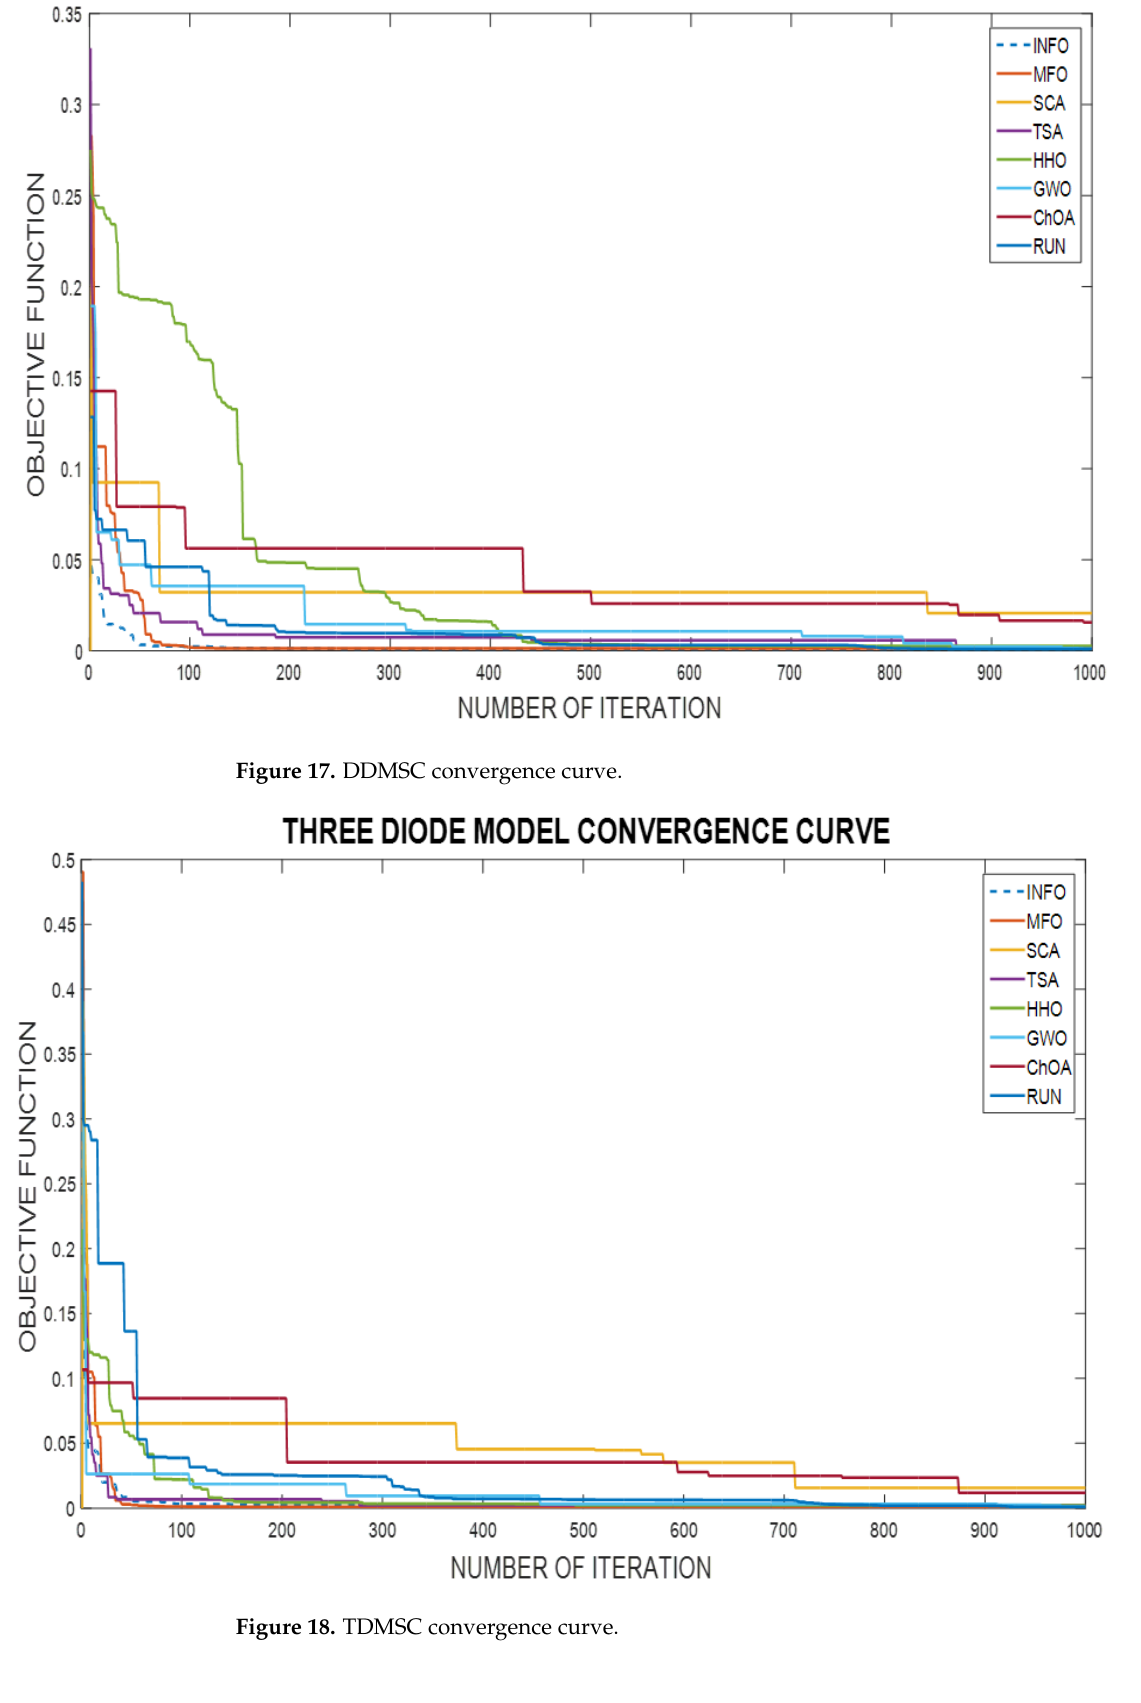
Figure 18. TDMSC convergence curve.